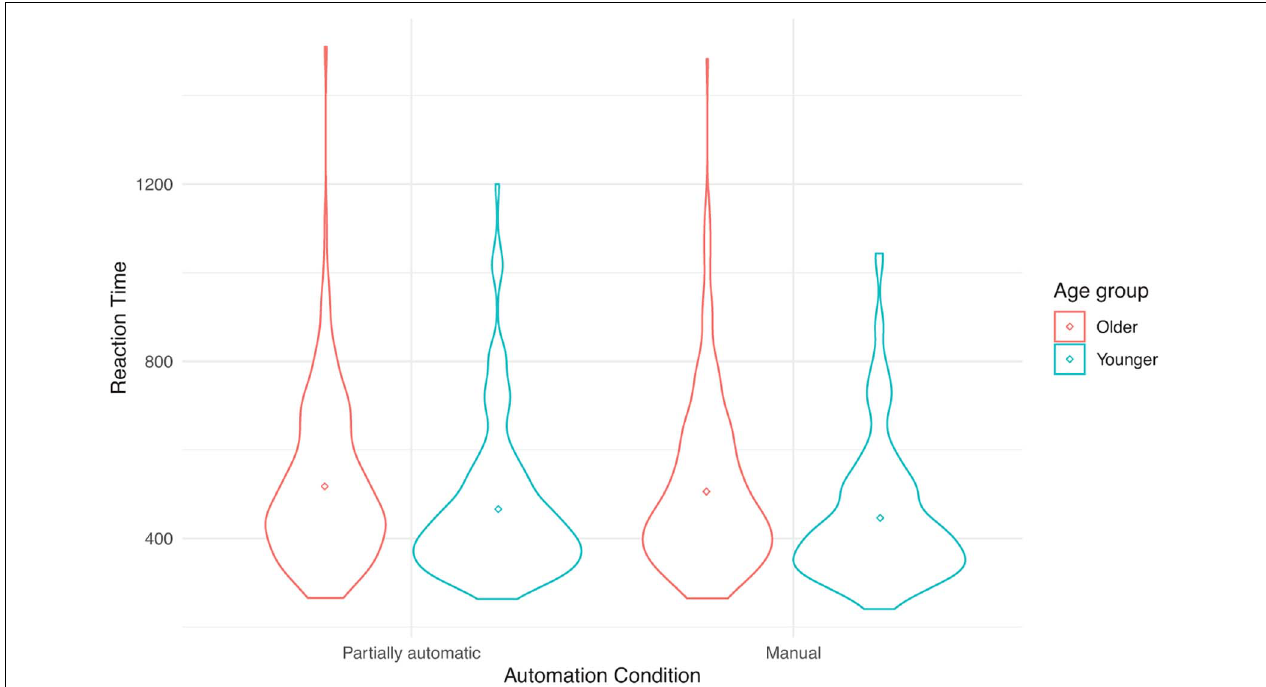
FIGURE 3 | Reaction time (in ms) performance on the Detection Response Task as a function of automation (manual and partial automation) and age (younger or